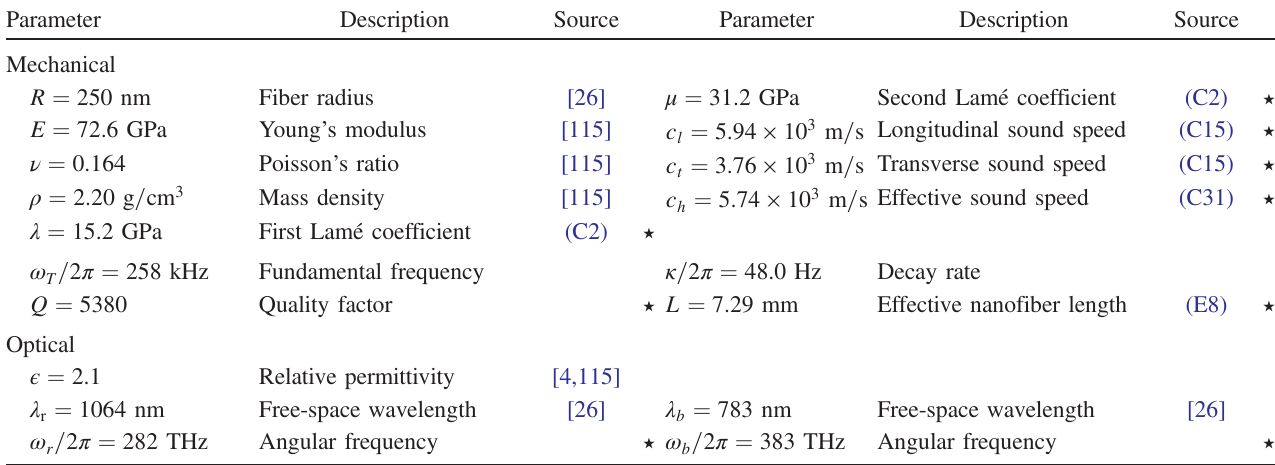
TABLE XVIII. Parameters for the case study in Sec. III. A star ( ⋆ ) indicates that a parameter depends on previously chosen